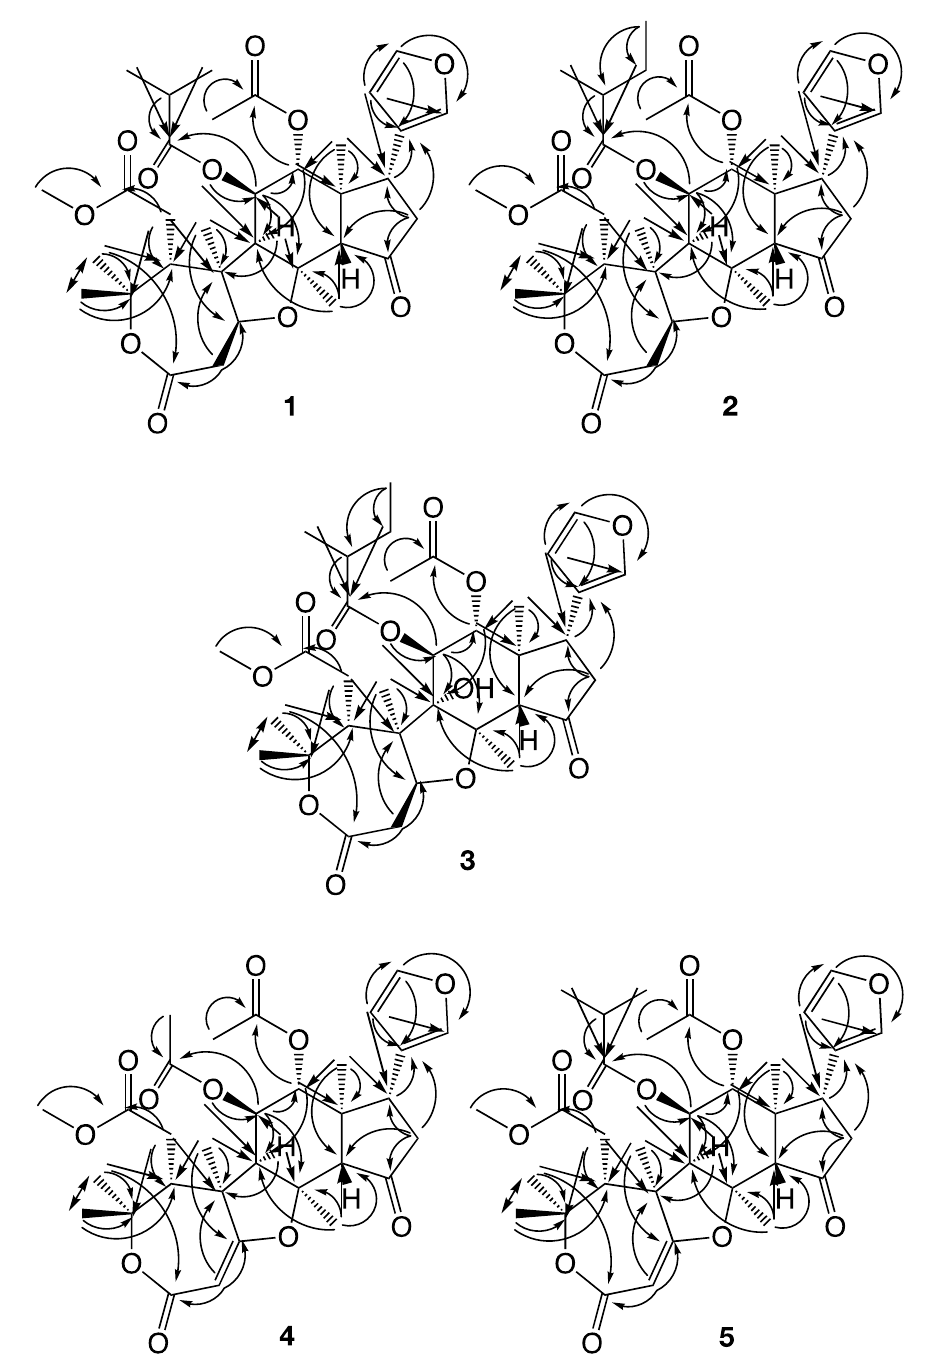
Figure 4. HMBC correlations observed with compounds 1 – 5 .